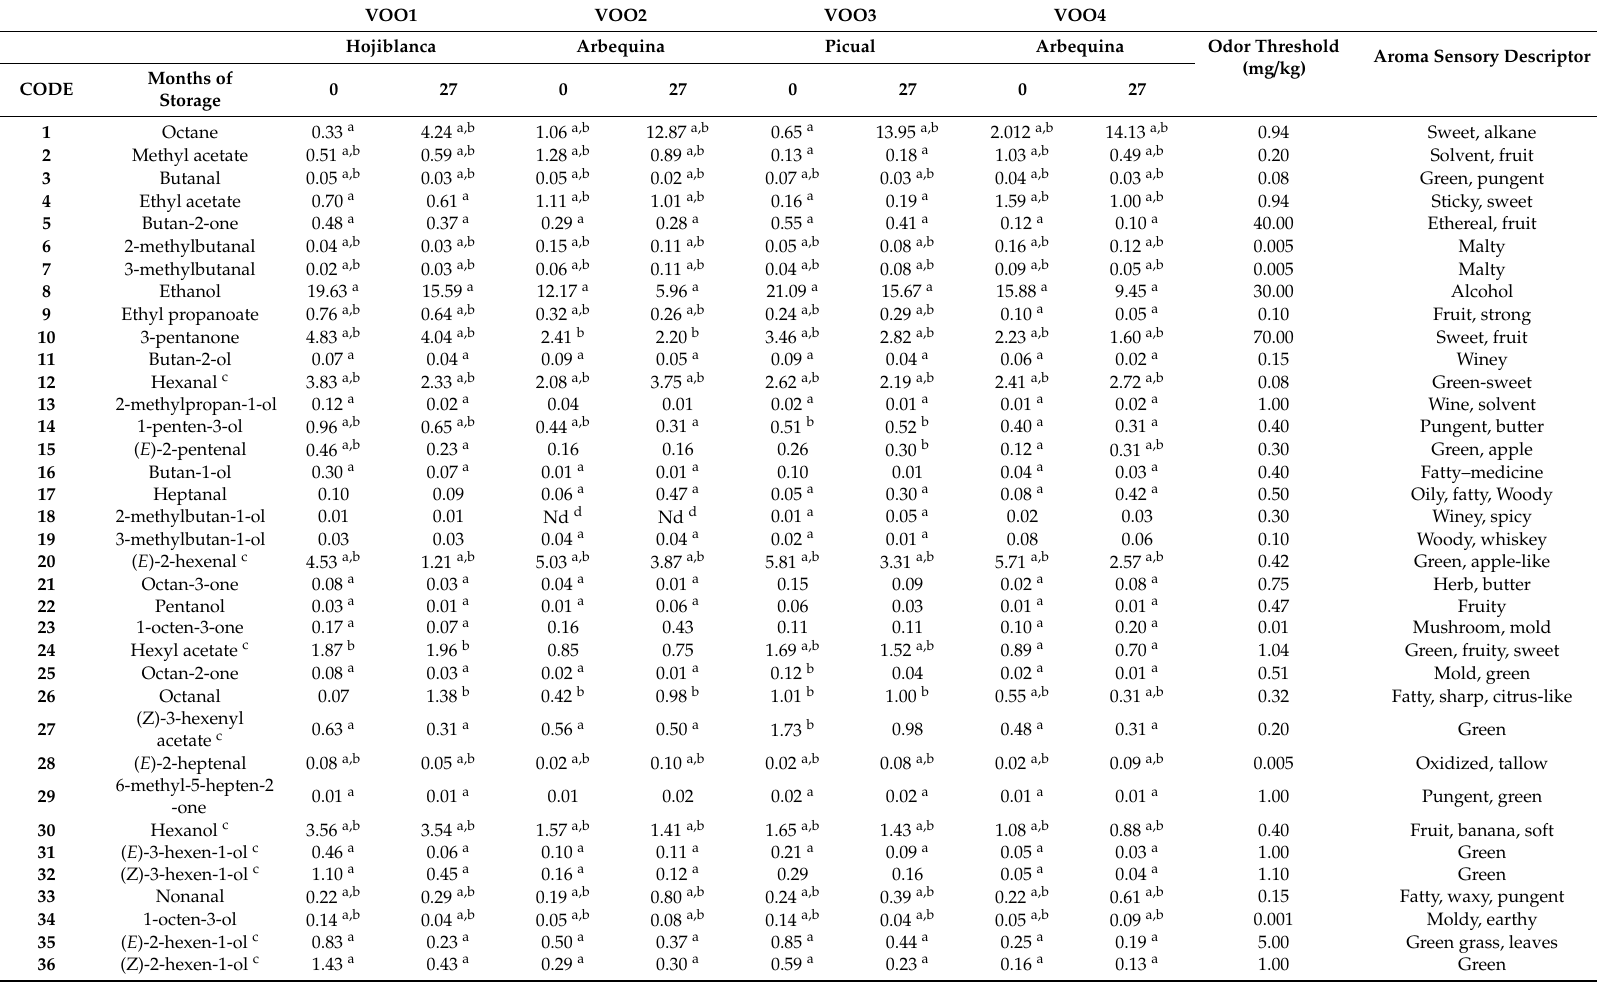
Table 2. Volatile compounds identified in the studied virgin olive oils, with their codes, their concentrations (mg / kg) at two di ff erent moments (before and after the storage experiment), the odor threshold and the sensory attributes of each volatile